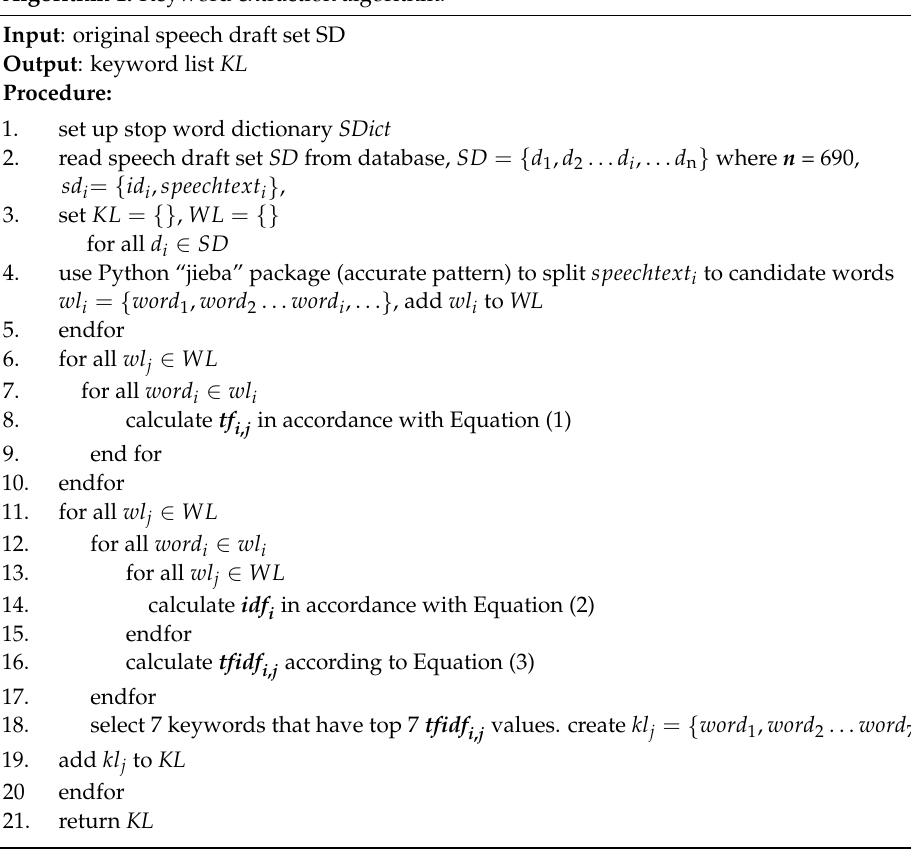
Algorithm 1. Keyword extraction algorithm.